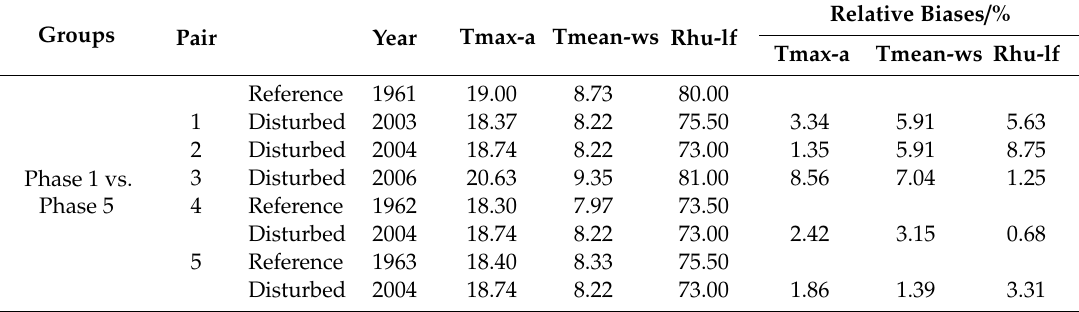
Table 3. Selected pairs for evaluating the e ff ects of hydropower dams on low flow regimes. Groups Pair